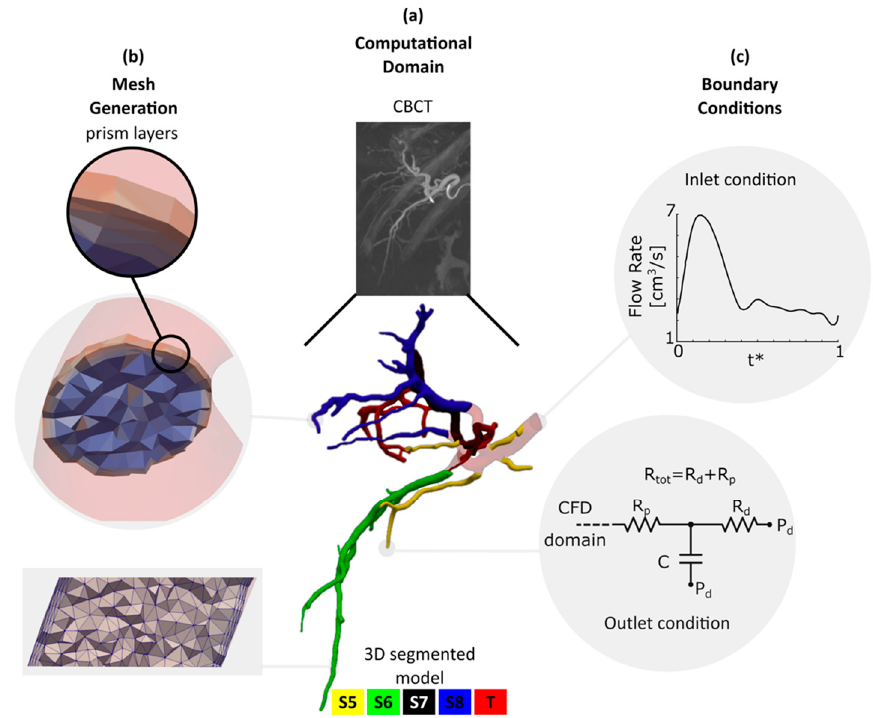
Figure 1. Computational domain, mesh generation and boundary conditions. ( a ) Computational domain: Cone-beam CT scan and the 3D segmented hepatic arterial tree color-coded according to Couinaud system. S5, S6, S7, S8 and T stand for liver segments 5, 6, 7, 8 and tumor, respectively; ( b ) mesh generation: mesh details and prism layers employed to resolve the governing equations in the boundary layers; ( c ) boundary conditions: inlet flow rate and the 3-element Windkessel circuit imposed at each outlet. A total of 23 simulations with di ff erent R tot and R d / R p were carried